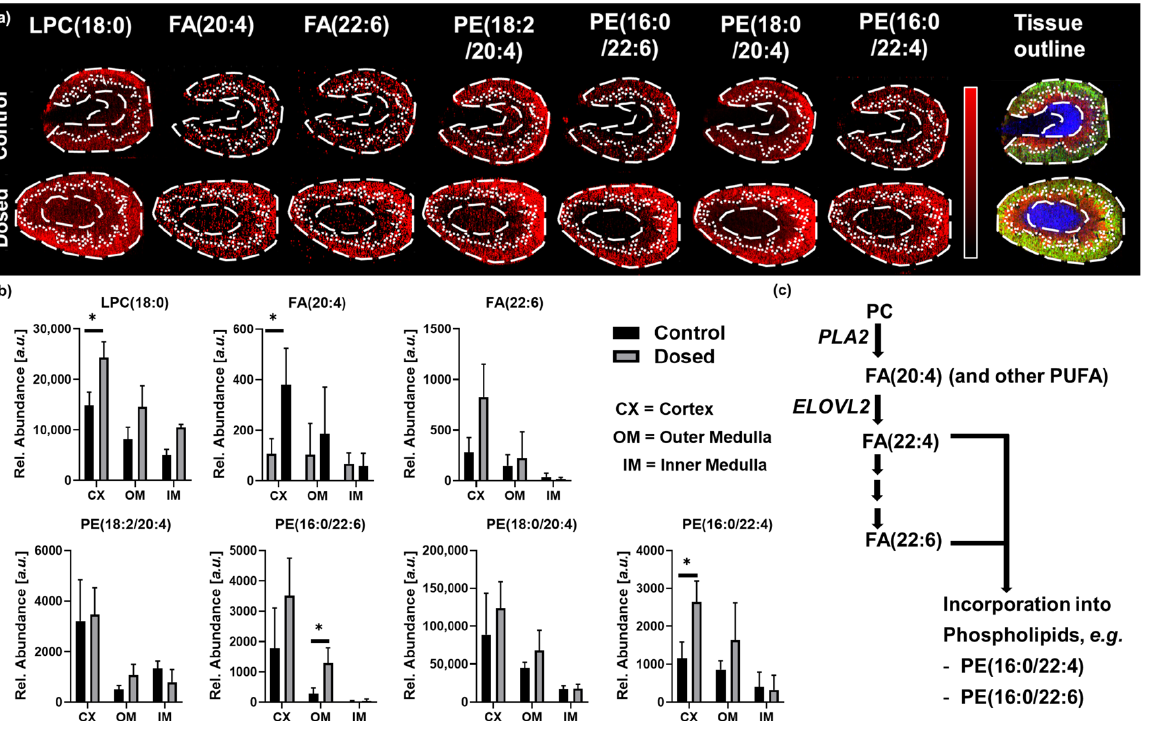
Figure 4. ( a ) Ion images for molecules associated with inflammation: LPC(18:0), fatty acid(20:4) (FA(20:4)), and fatty acid (22:6) (FA(22:6) and resolved pairs of the isobaric phospholipids PE(18:2/20:4) and PE(16:0/22:6), PE(18:0/20:4), and PE(16:0/22:4), respectively. The RGB image with the tissue outlines for inner medulla (blue), outer medulla (red), and cortex (green) for control and dosed sections. ( b ) shows the relative abundance of the metabolites highlighted in a. Data are presented as mean + standard deviation of 4 randomly chosen ROIs across cortex, outer and inner medulla. Statistical significance was determined via two-tailed, non-parametric test (Mann-Whitney); Significance level * = p < 0.05 ( c ) Metabolic pathway scheme for the detected